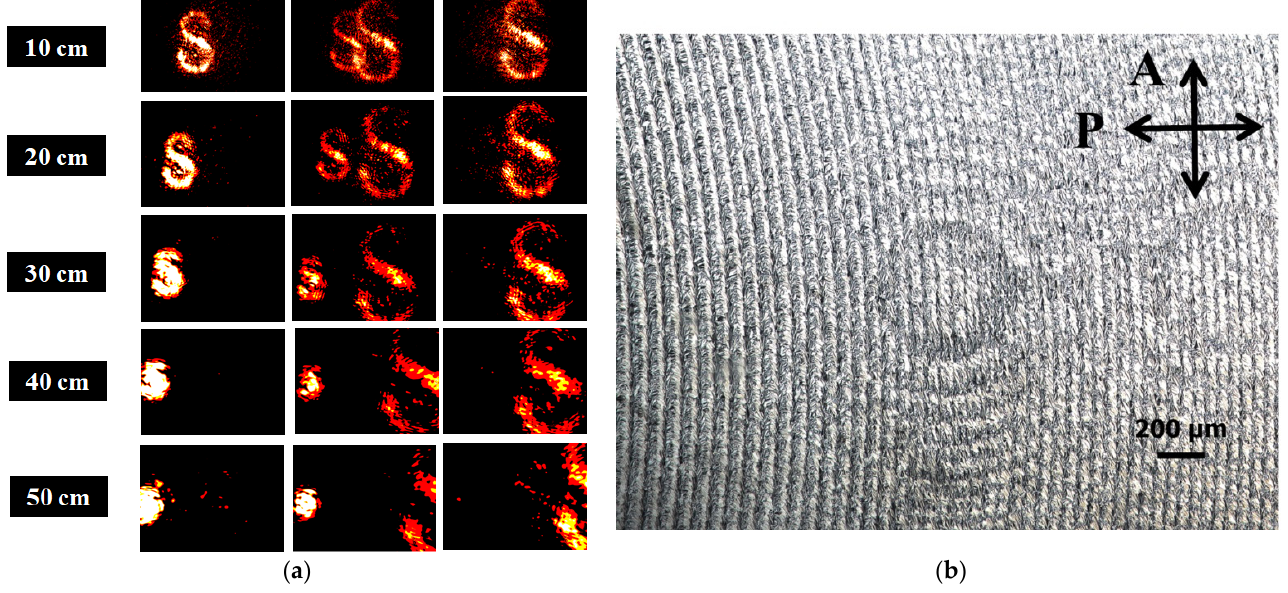
Figure 8. ( a ) Experimental results of the light field captured at different positions away from the FLC compound lens with left-handed circularly polarized incident light (left), linearly polarized incident light (middle) and right-handed circularly polarized incident light (right). ( b ) Microscopic photograph of the fabricated FLC lens.